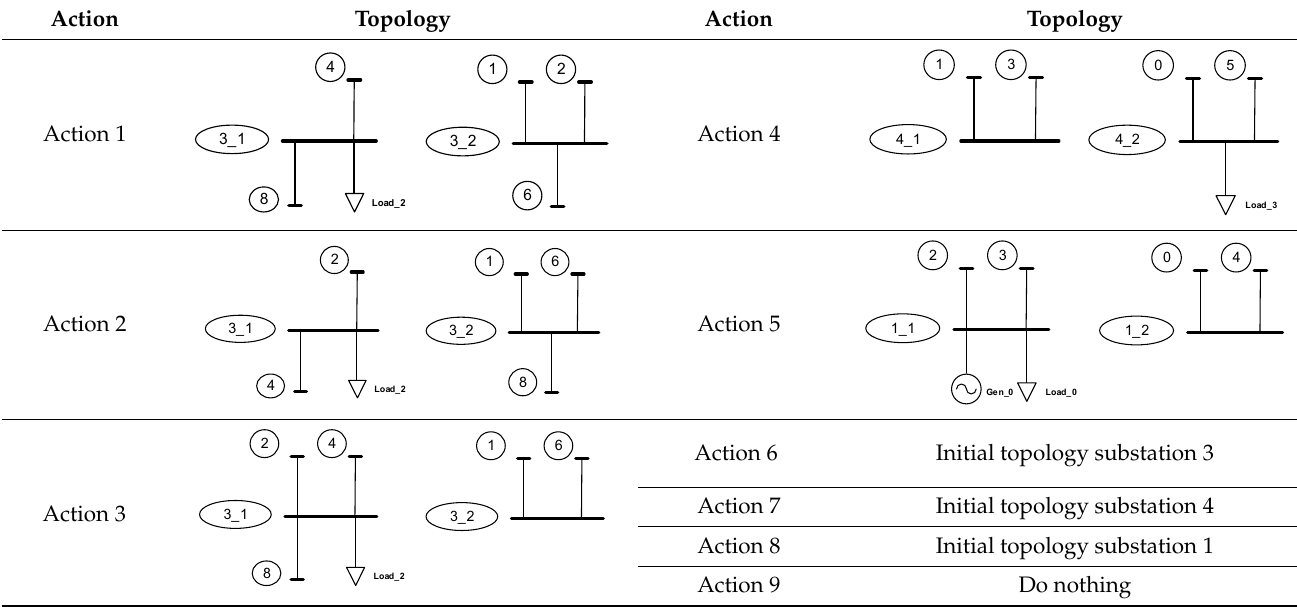
Table 4. Main observation